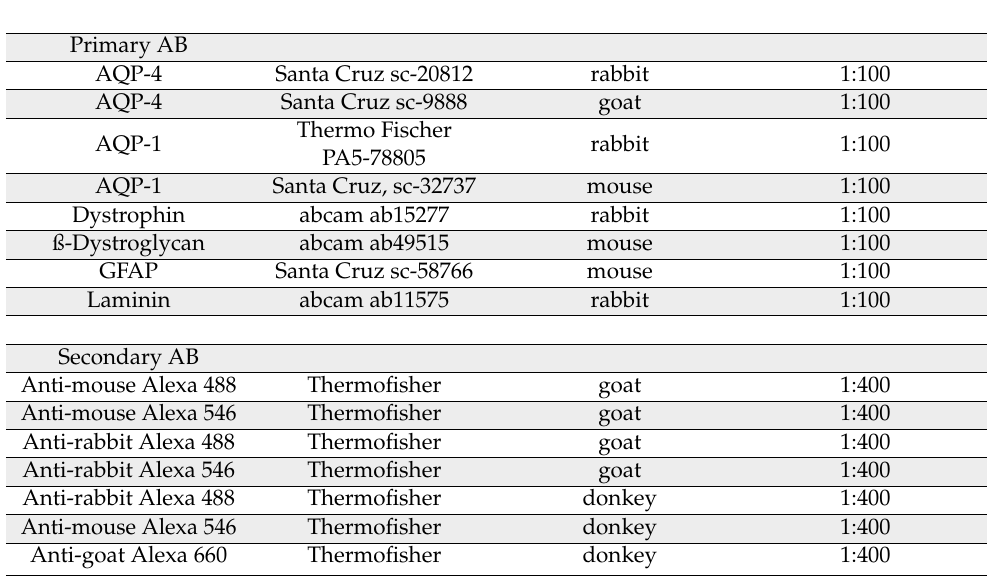
Table 1. Primary and secondary antibodies used in this